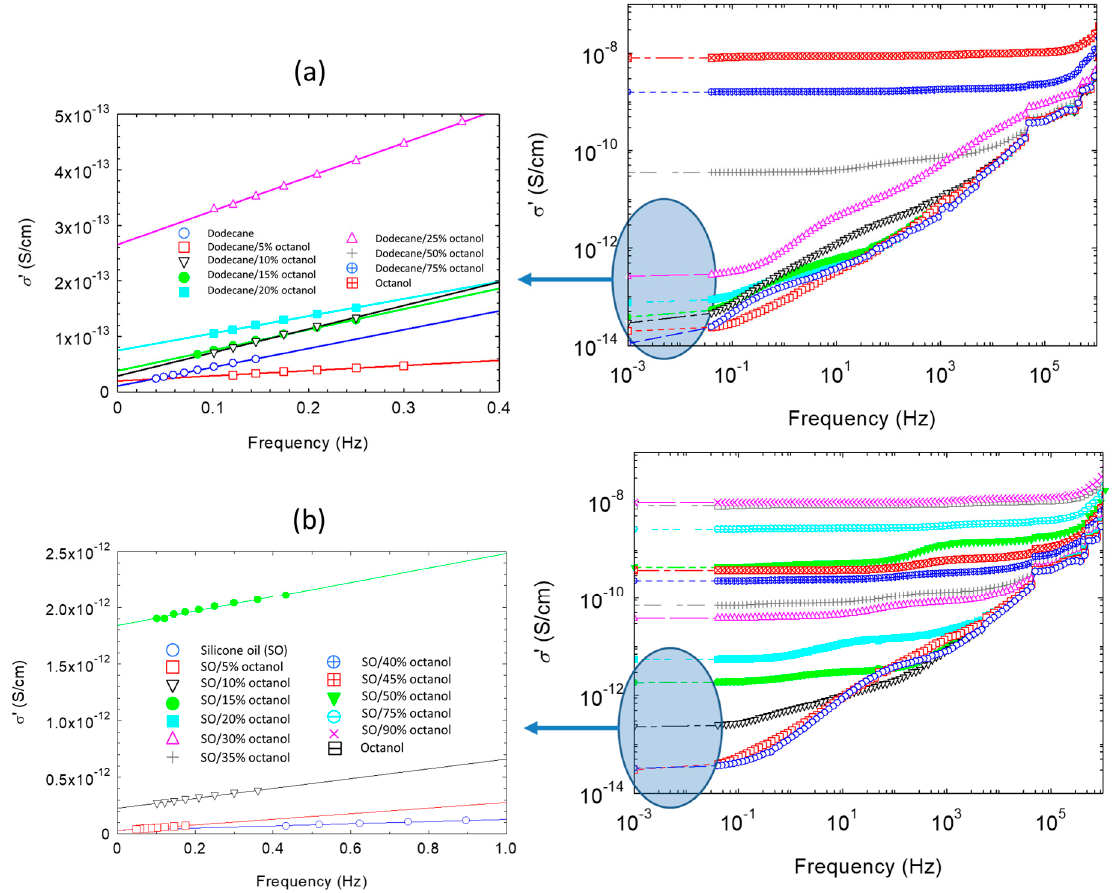
Figure 5. The effects of measurement frequency on the real part of the electrical conductivity, σ ′ , for octanol mixtures (wt% concentrations indicated in the plots to the left) with ( a ) dodecane, and ( b ) silicone oil. The dashed lines represent linear extrapolations to the σ ′ DC values at zero frequency (as shown in the respective plots to the left).